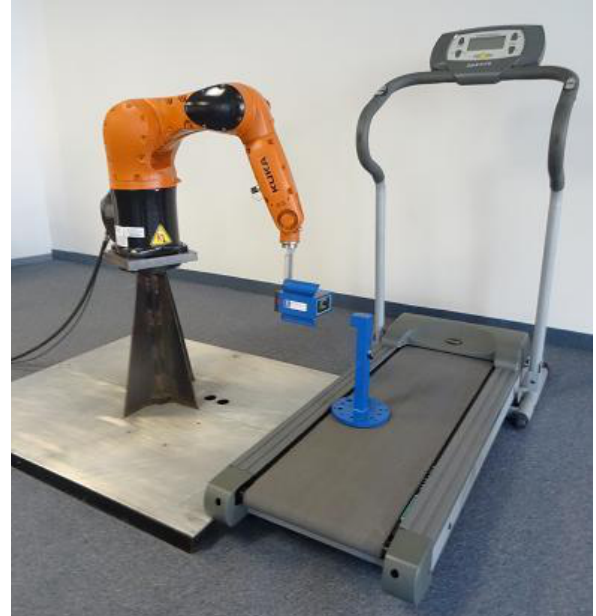
Figure 8. Laboratory installation that creates additional degree of freedom of